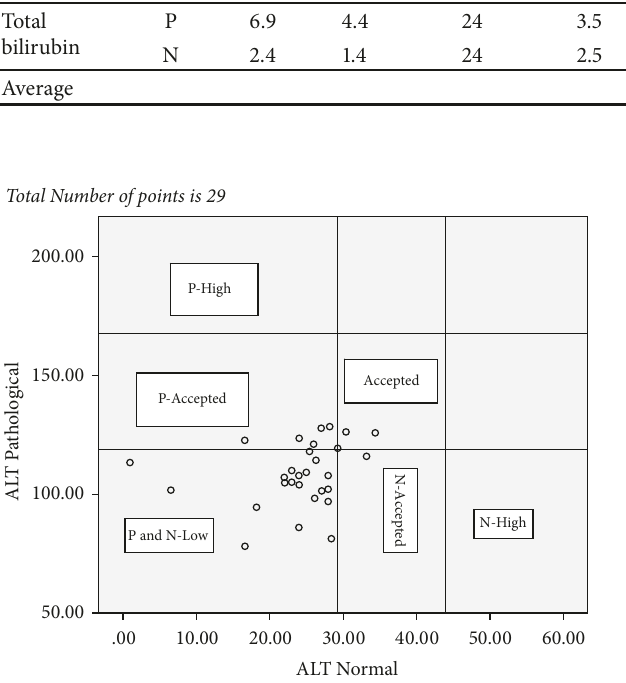
Figure2:PlotofcontrolsampleglucosepathologicalPvaluesversus control sample glucose normal N values for the total of 29 reported points. P: pathological; N: